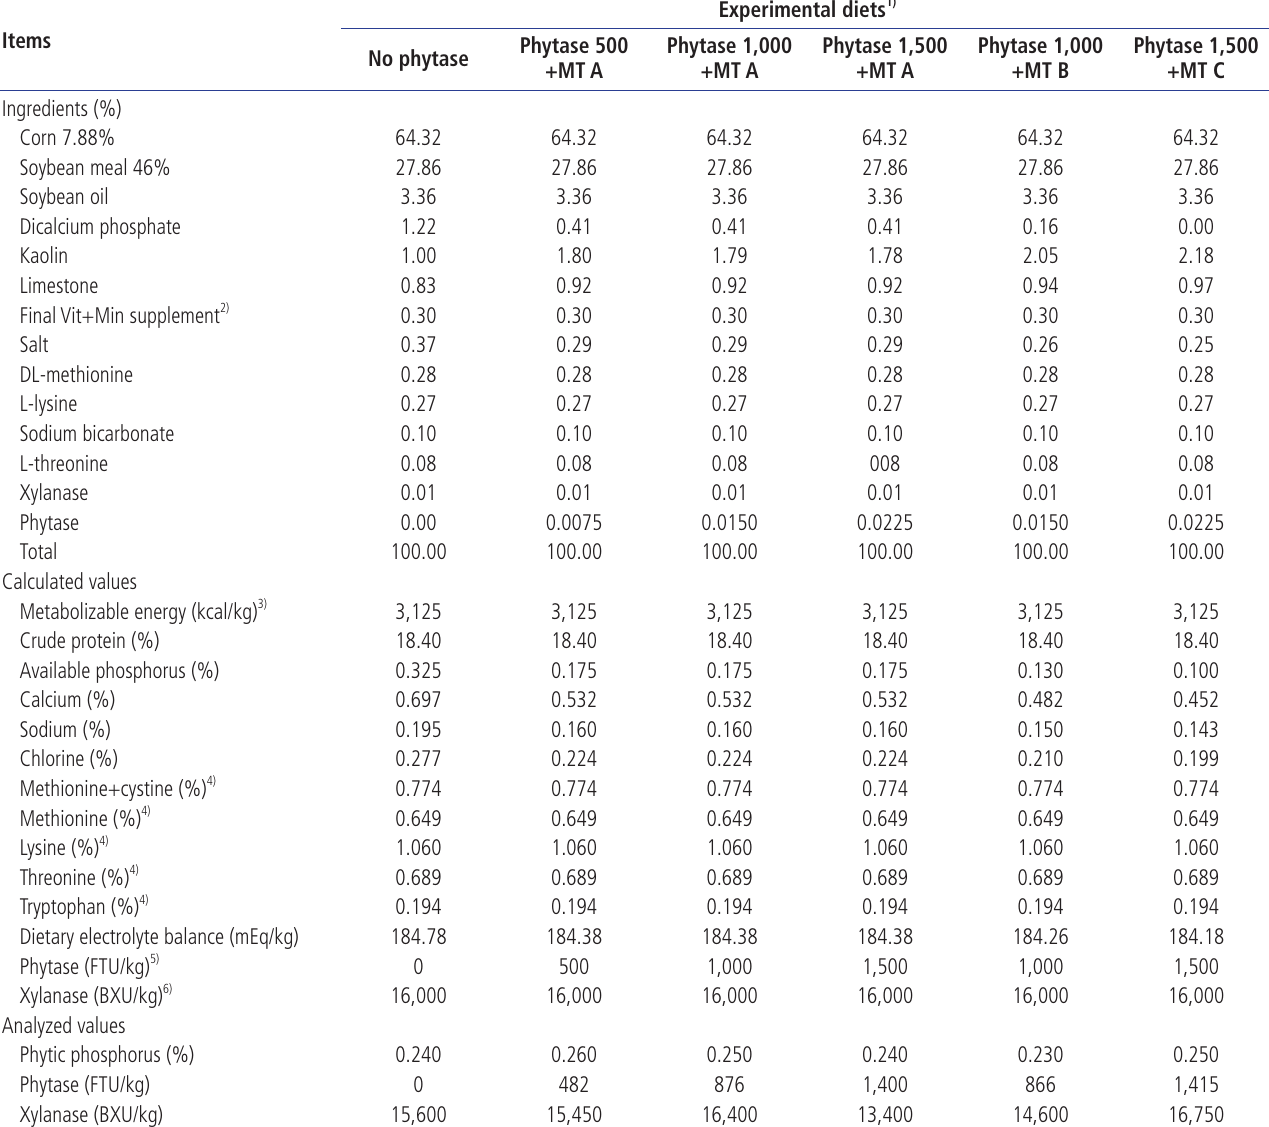
Table 4. Nutritional composition and calculated values of broiler experimental diets (34 to 42